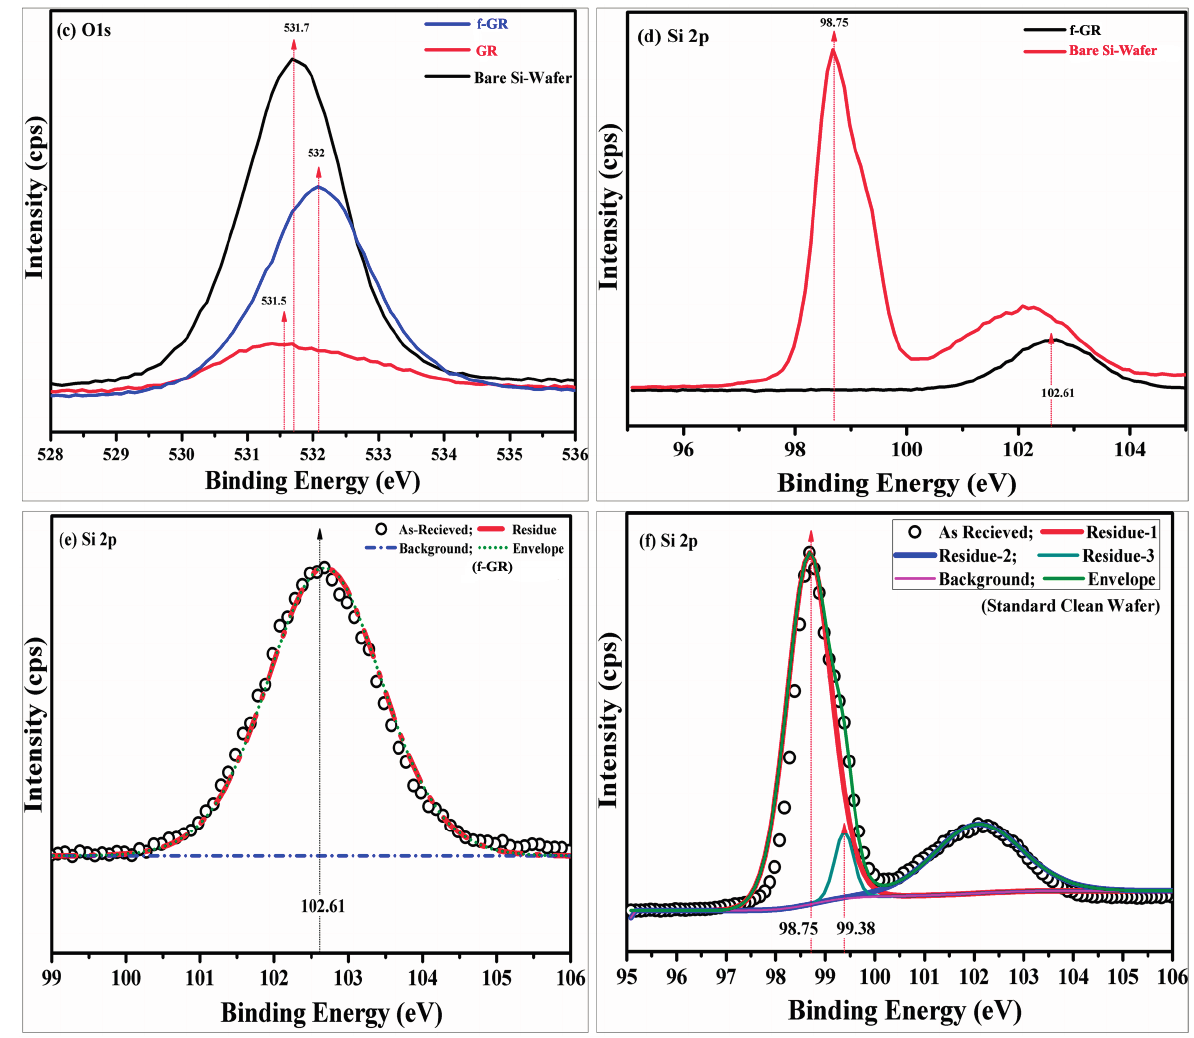
Figure 11. X-ray photoelectron spectroscopy results of graphene, f-graphene and bare Si-wafer (cleaned): ( a ) complete core survey of samples; ( b ) C-1s spectra of raw graphene, f-graphene and bare Si-wafer samples; ( c ) O-1s spectra; ( d ) Si-2p spectra; ( e ) peak fitting of the Si-2p spectra of f-graphene; ( f ) peak fitting of the Si-2p spectra of standard, cleaned, bare Si-wafer. cps = counts per